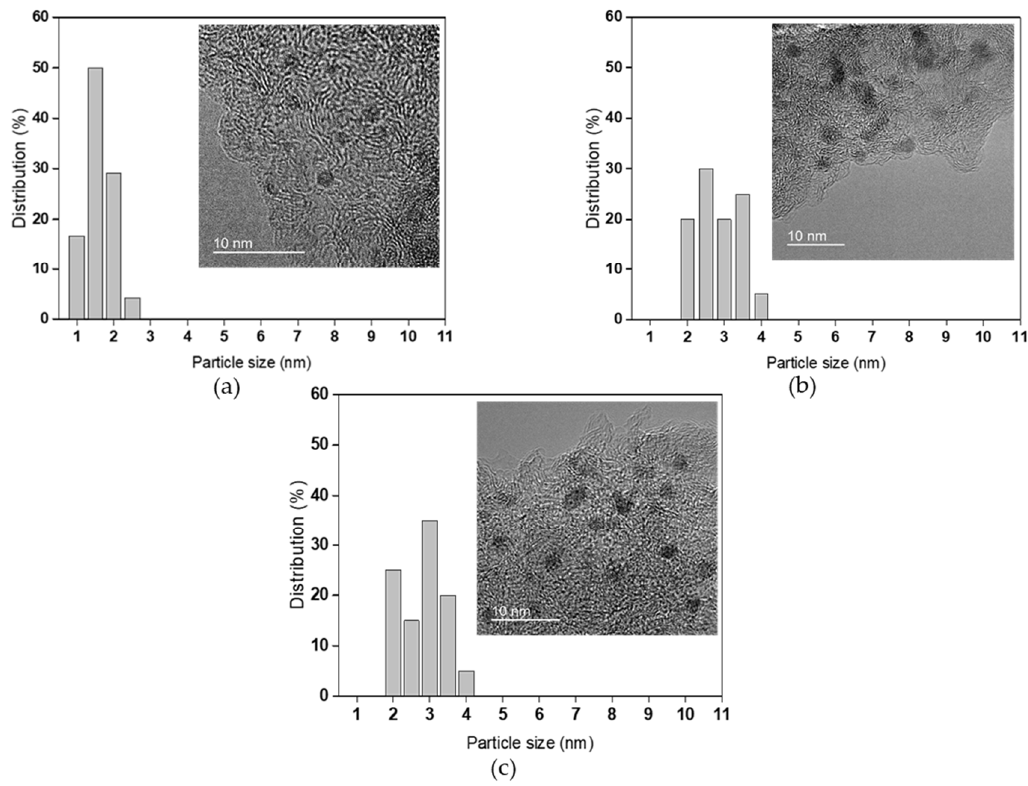
Figure 1. High-resolution transmission electron microscopy images of fresh Ru/C ( a ), Pd/C ( b ), and Pt/C ( c ).